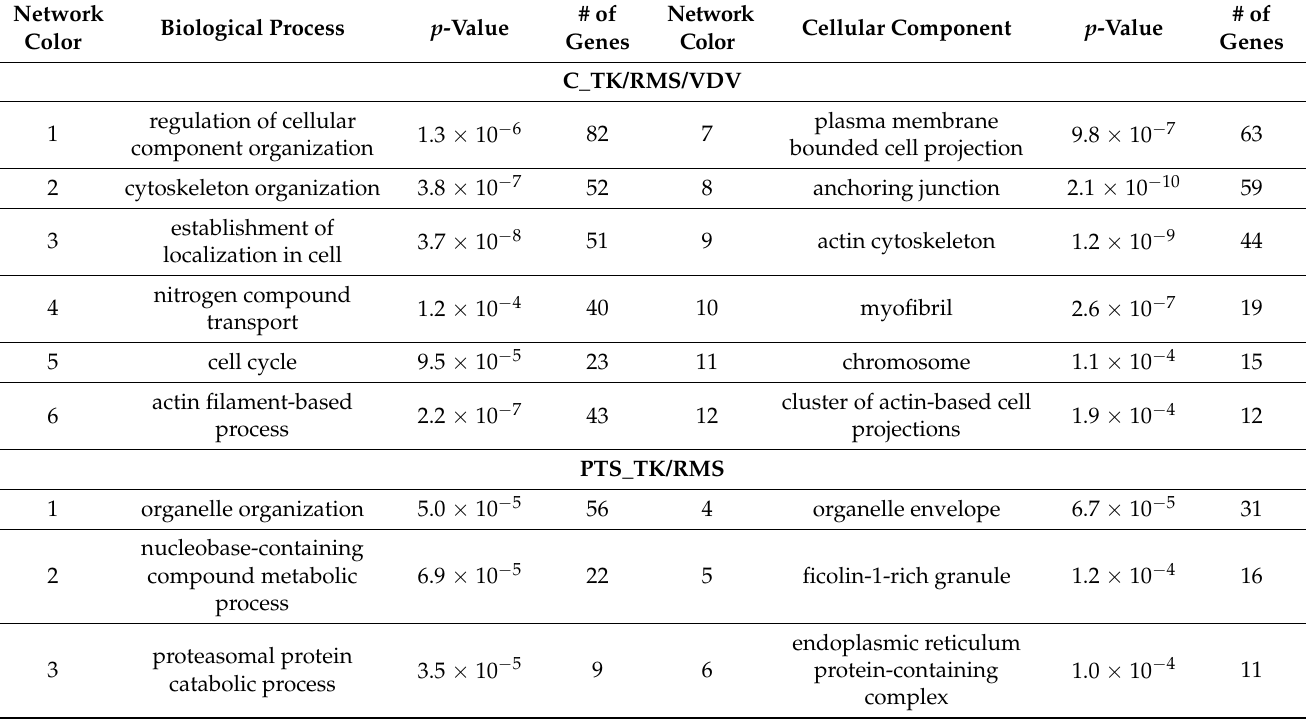
Table 4. Significantly enriched GO terms in correlating transport metric lists. The network color code refers to Figures